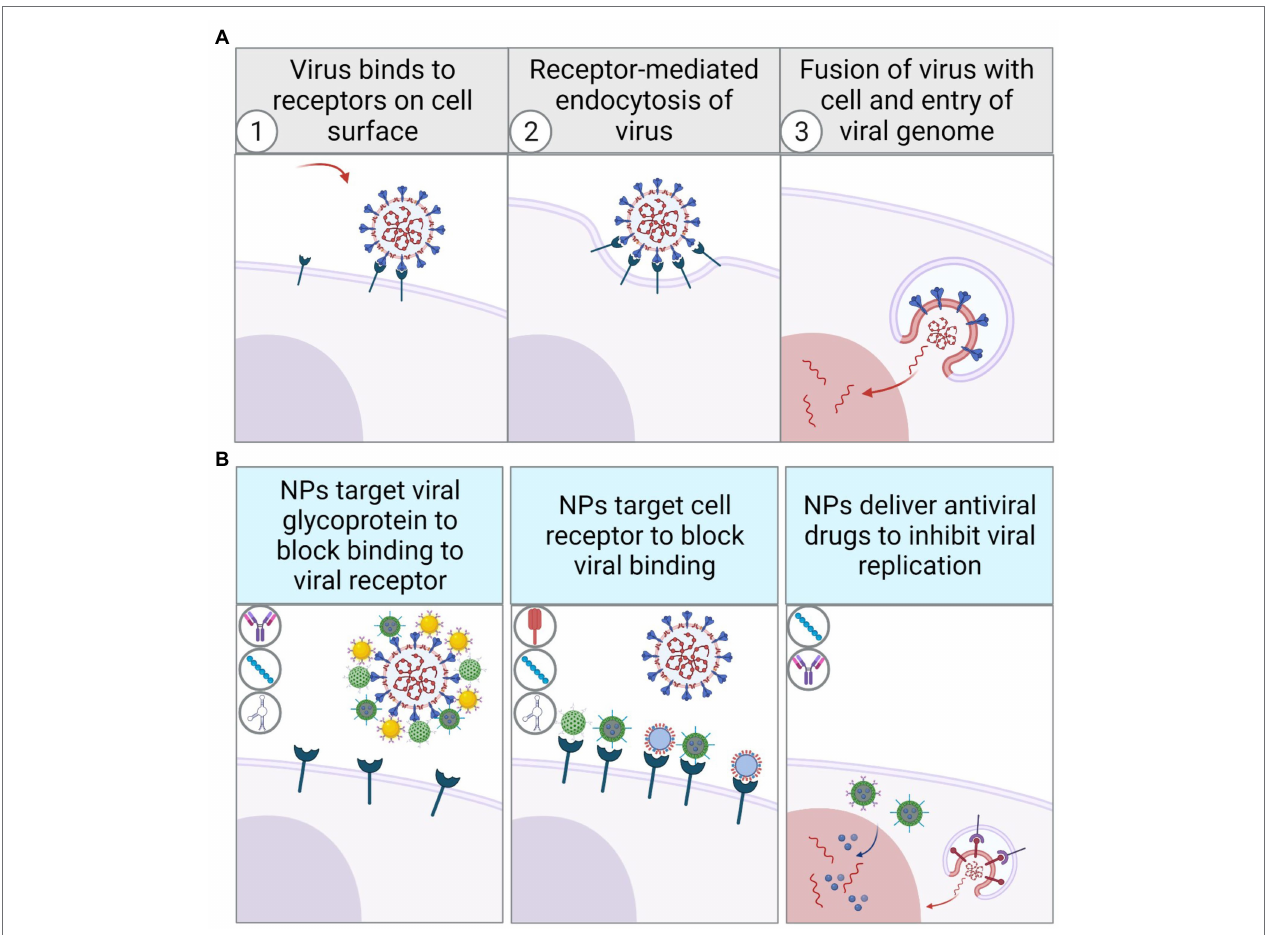
FIGURE 4 | Schematic diagram of virus recognizing cell surface receptors to invade and replicate in host cells through receptor-mediated endocytosis (A) . Schematic diagram of viral inhibition by functionalized NPs with different surface modifications (B)